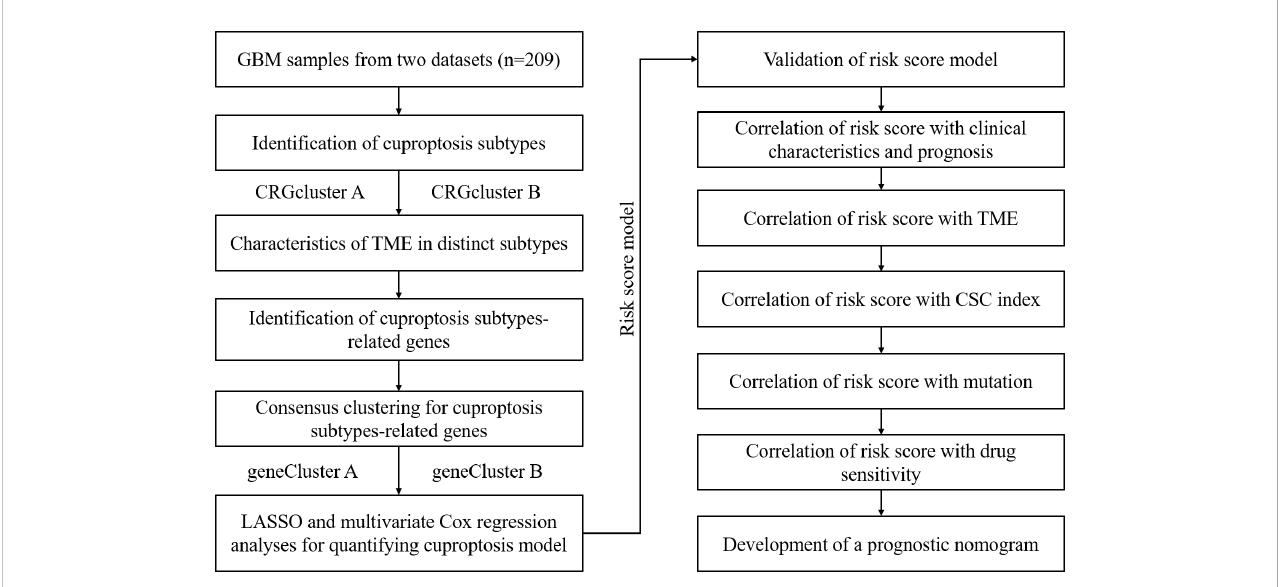
FIGURE 1 The entire analytical process of the